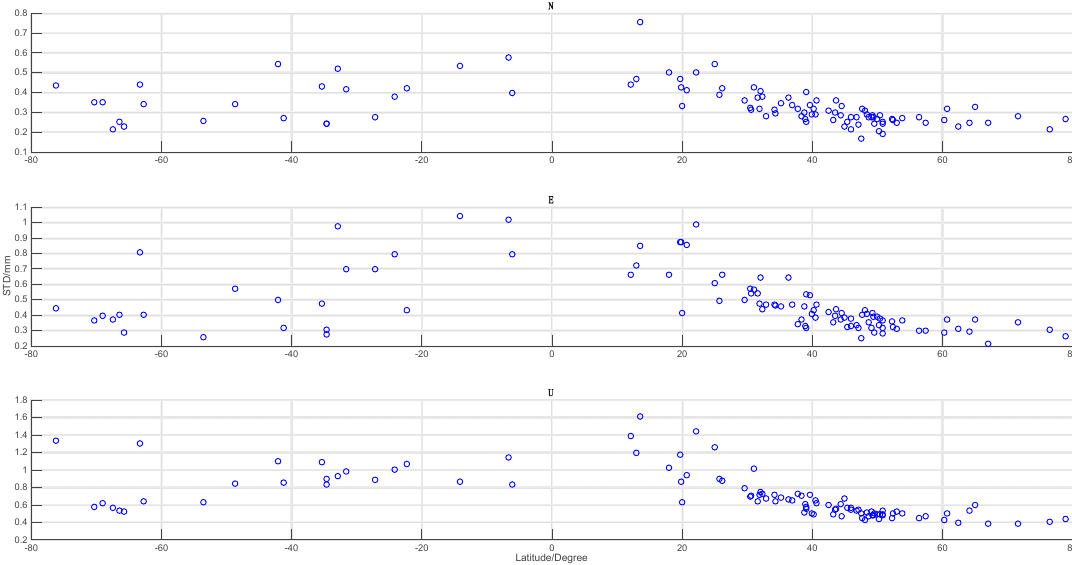
Figure 4. The STD of the S1/S2 induced GPS coordinate time series with respect to the latitude. From top to bottom are the North (N), East (E), and Up (U) components. The units are in mm.